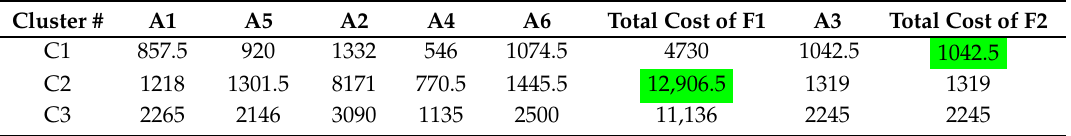
Table 16. TACC decision allocation matrix, [7].